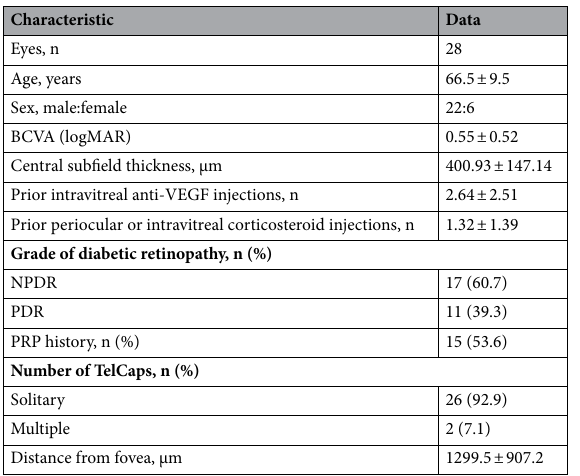
Table 1. Baseline characteristics of patients included in the study. Values are presented as mean ± standard deviation or percentages. BCVA best-corrected visual acuity, LogMAR logarithm of the minimum angle of